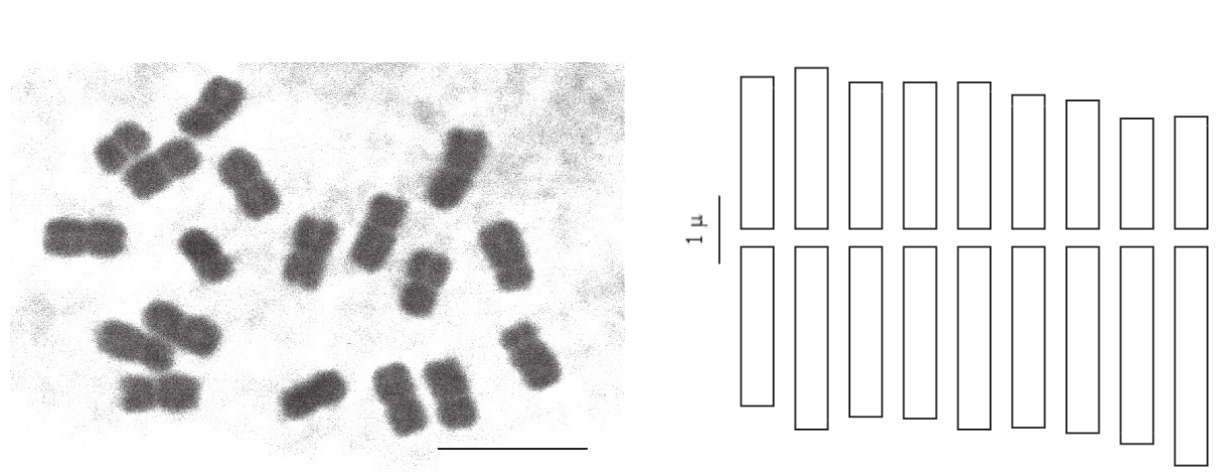
Figure 1. Somatic metaphase in A. spicigera (2 n= 18), and haploid idiogram (Scale bars: 1